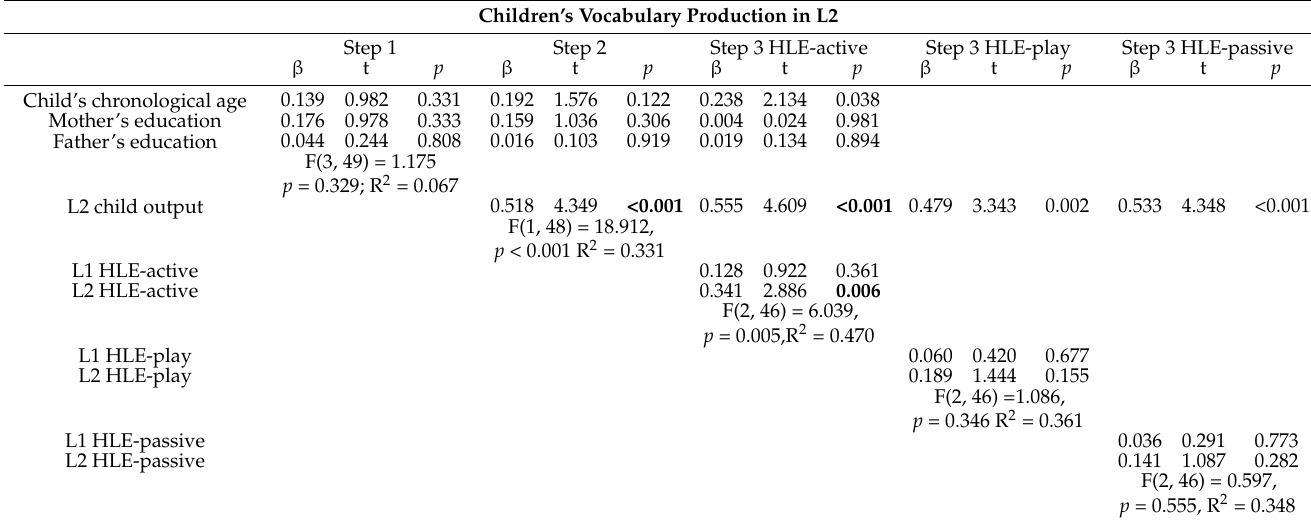
Table 5. Summary of the three stepwise regression analyses with step 3, including separate practices (active, play, and passive) for children’s vocabulary production in